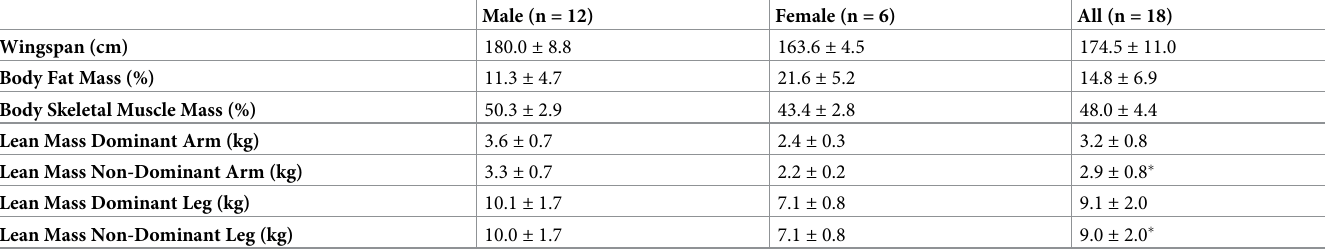
Table 2. Wingspan and body composition for all